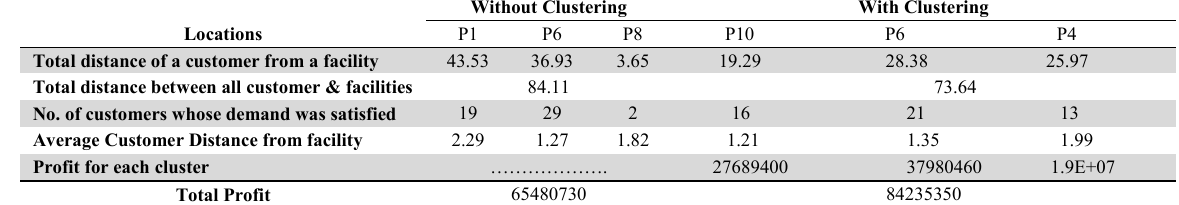
Without Clustering